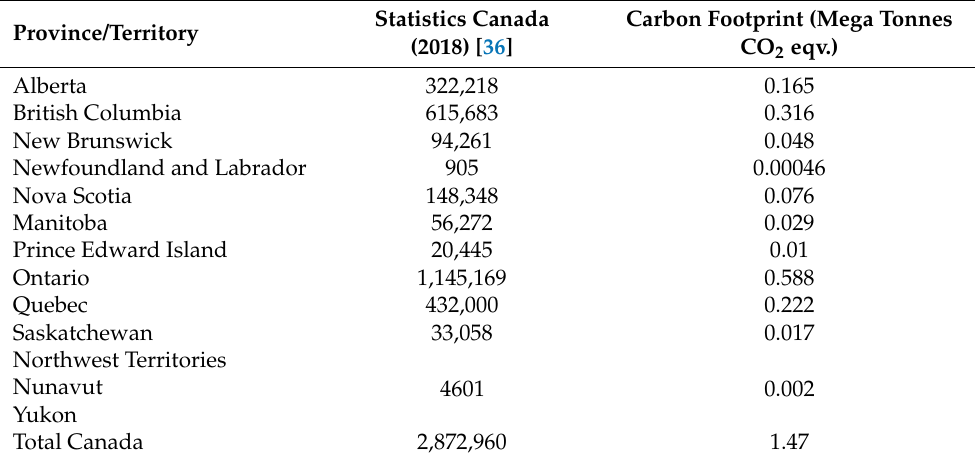
Table 3. Carbon footprint calculation from organic waste using CCaLC2 (Mega Tonnes CO 2 eqv.) in